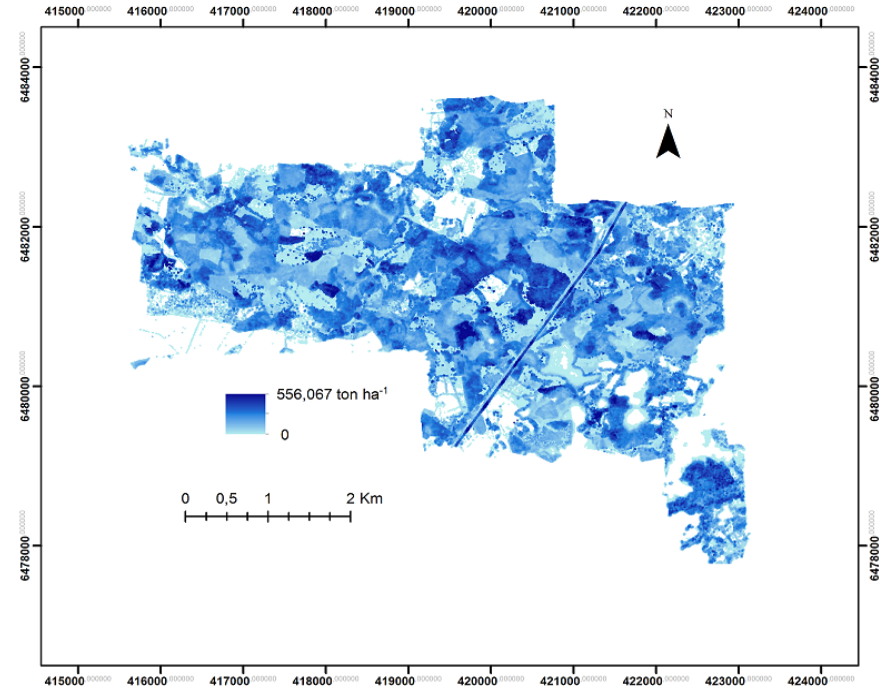
Figure 12. Resulting biomass map from the RMoG L